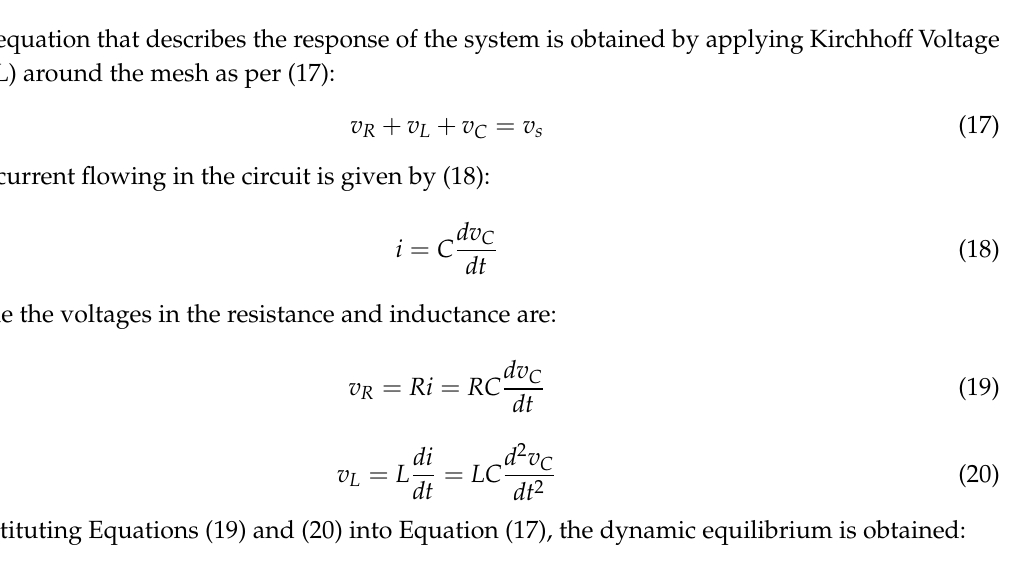
Figure 1. Second order RLC circuit for PZT (implicit capacitance)